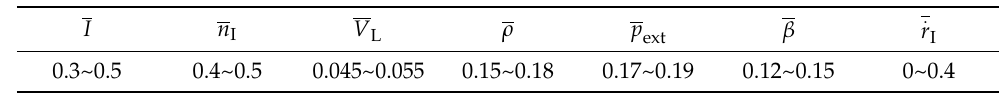
Table 2. Dimensionless